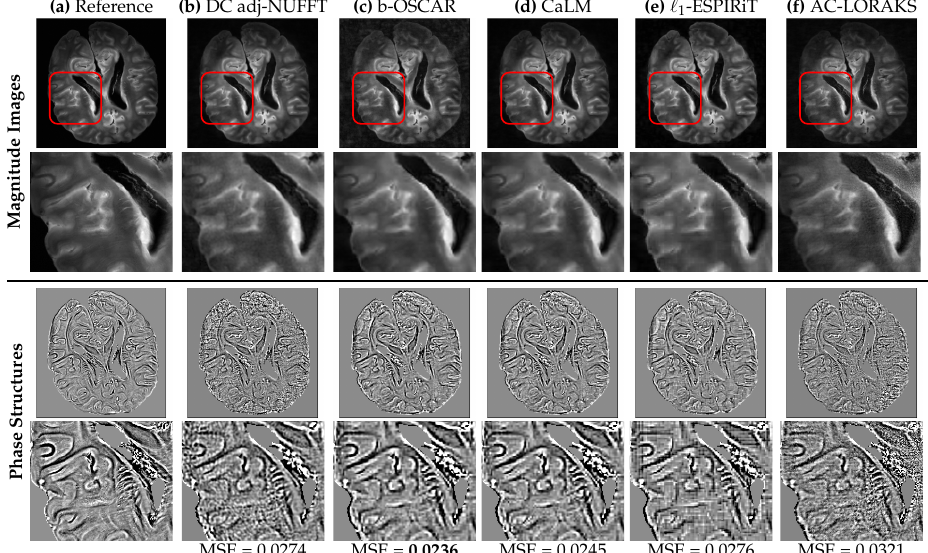
Figure 6. Top Row: Reconstructed MR images (magnitude) from 20-fold accelerated SPARKLING acquisitions using different methods. The scan time for Cartesian reference was 4min41s while the scan time of accelerated SPARKLING was 15s. (a) Cartesian reference. (b) The density compensated adjoint of raw k-space data (DC adj-NUFFT). (c) Reconstruction based on the b-OSCAR formulation. (d) calibration-less reconstruction based on CaLM or group-LASSO regularization. (e) Self-calibrating ‘ 1 -ESPIRiT reconstruction. (f) Auto-calibrated (AC) LORAKS reconstruction. Second Row: Respective zooms in the red frame. Reconstructed MR images. Third Row: Enhanced structures in phase images obtained by the method described in Sec. 4.5 on the virtual coil reconstructions of each method. The respective MSE of the phase images with respect to Cartesian reference are also reported. Bottom Row: Respective zooms to highlight details.